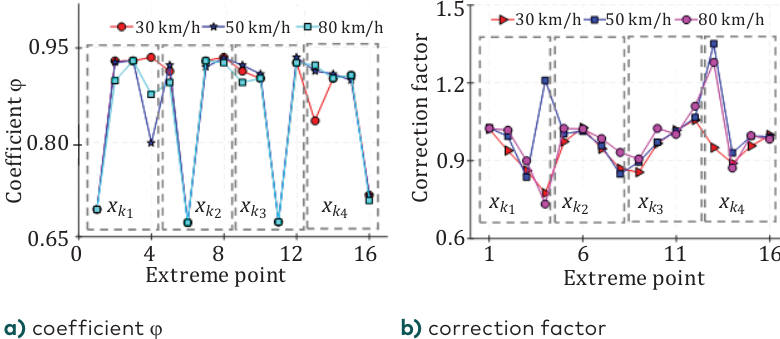
Figure 13. Comparative analysis of different vehicle velocities